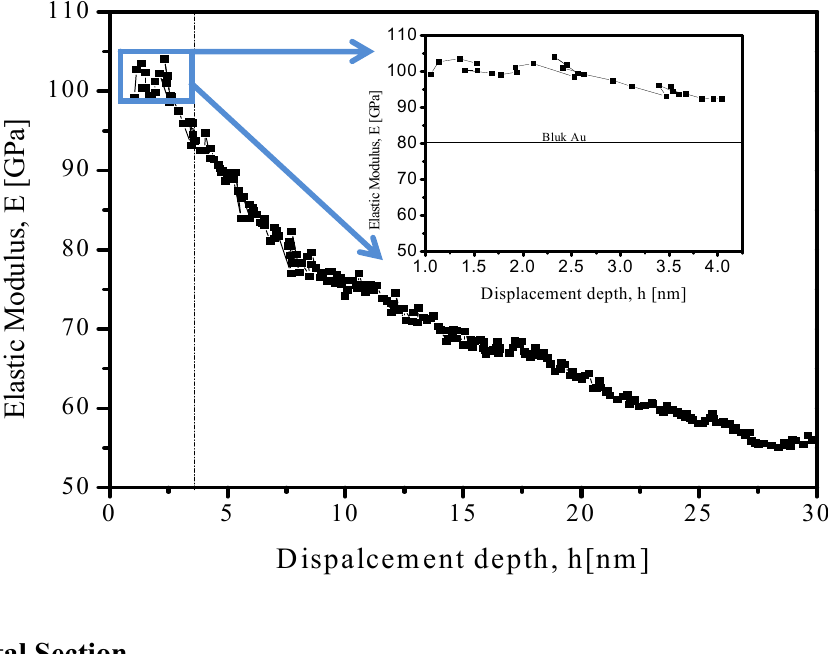
Figure 4. Measurements of elastic modulus as function of displacement from CSM nanoindentation of Au-NP. Inset: Specific region between 1.0–4.0 nm of displacement, indicating a 100 ± 2 GPa value. Horizontal dotted line corresponds to values found for gold in bulk phase